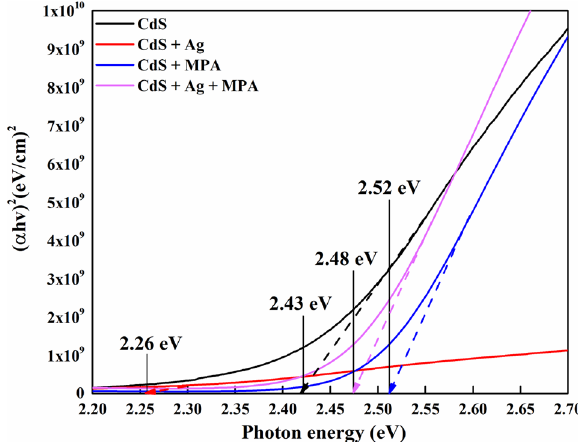
Figure 2. Difference of ( αhν ) 2 with photon energy ( hν ) for CdS thin